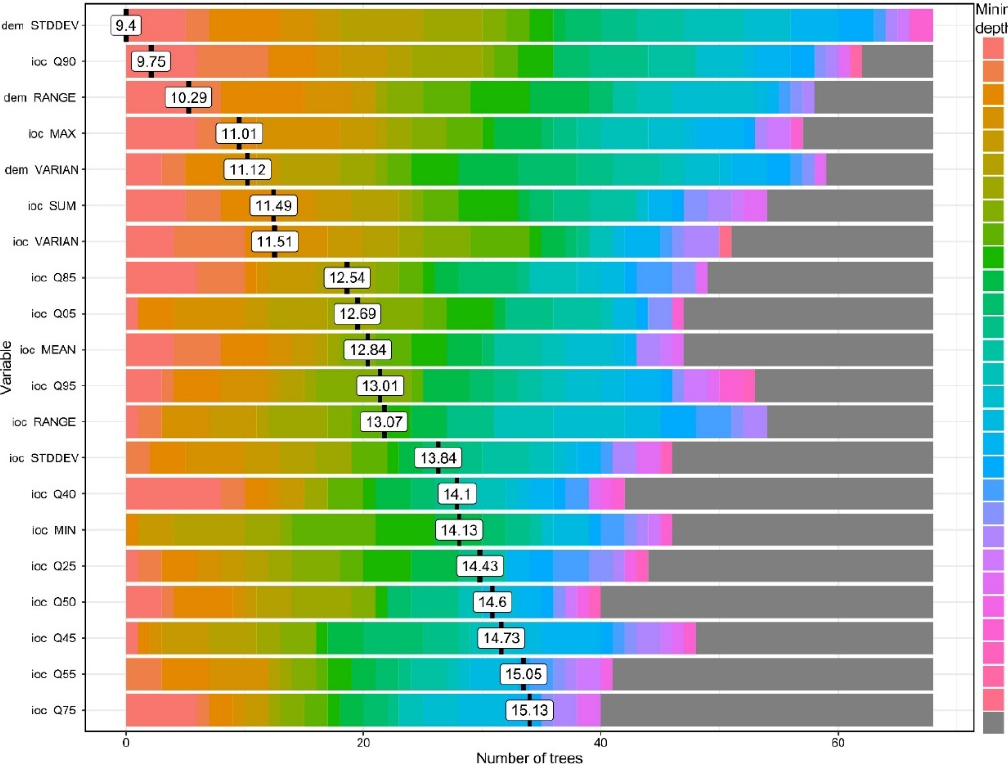
Figure 11. The plot of the minimal tree depth and its mean. (a high-resolution version can be found at https://doi.org/10.6084/m9.figshare.11798667.v1)